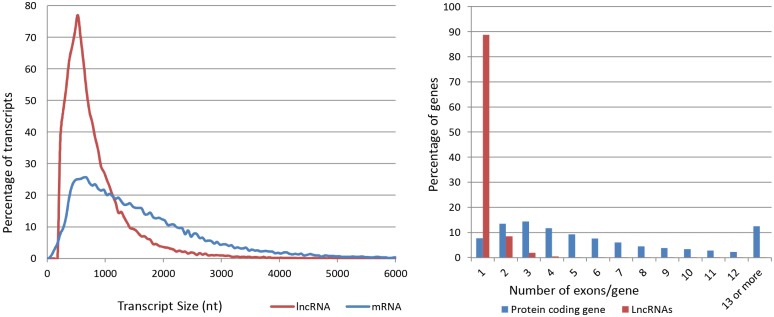
Distribution of sequence length of LncRNAs compared to protein-coding transcripts in rainbow trout.LncRNAs were shorter than protein-coding genes with (0.821 kb) and (1.636 kb) average length in each, respectively (Left). Distribution of number of exons in LncRNAs compared to that of protein-coding genes. Most LncRNA transcripts (~90%) have only one exon whereas majority of the protein-coding transcripts tend to have two or more exons (Right).